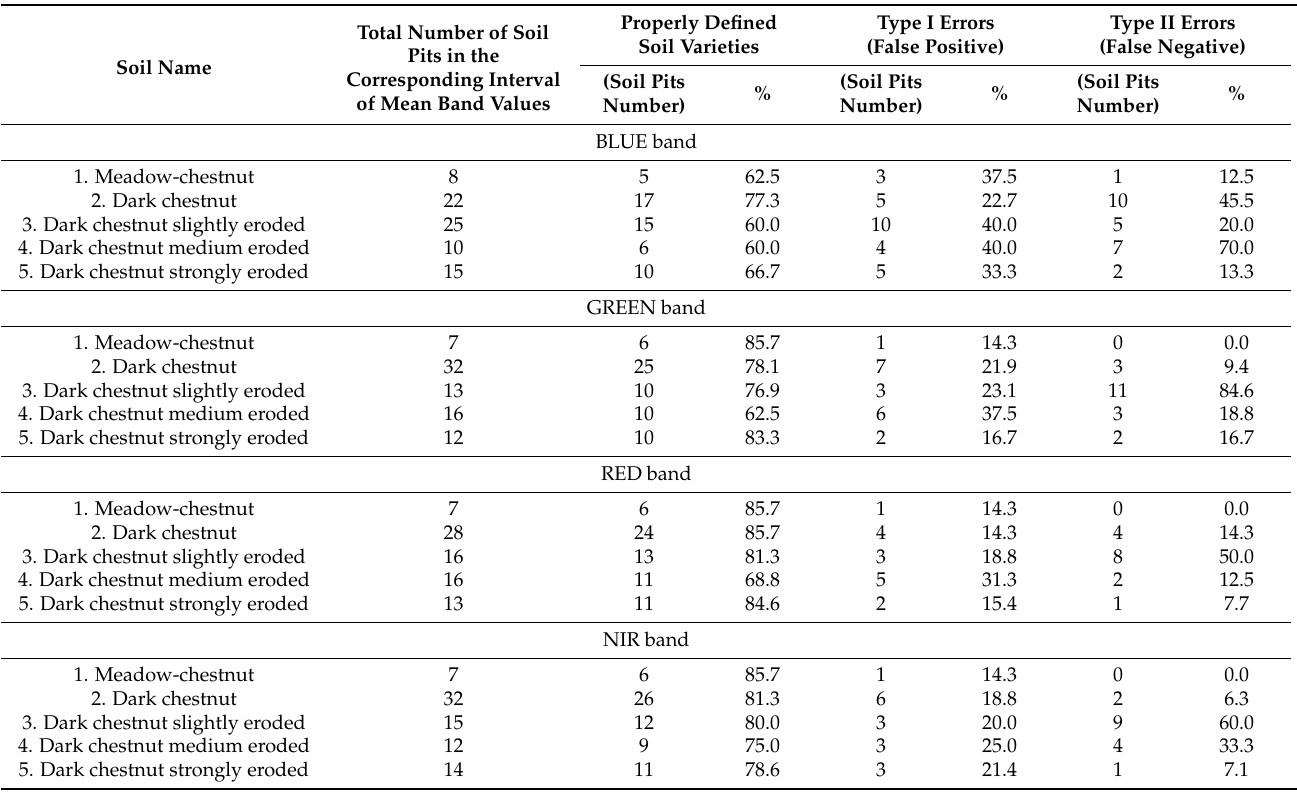
Table 3. Type I and II errors for soil varieties